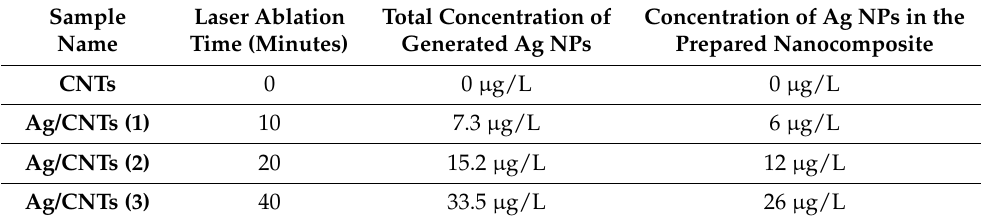
Table 1. Calculation of total concentration of Ag for the different prepared nanocomposites by AAS.